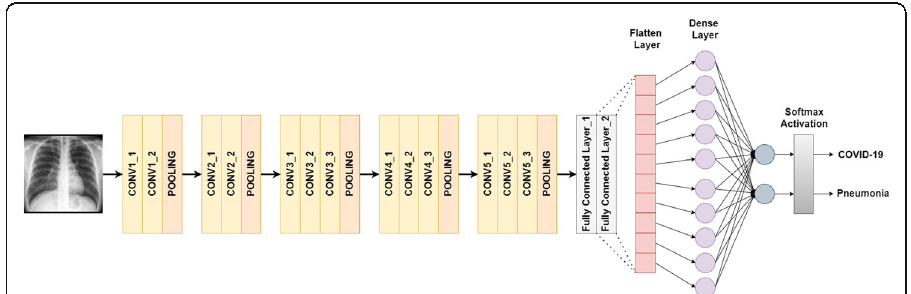
Fig. 1 VGG16 architecture designed for binary